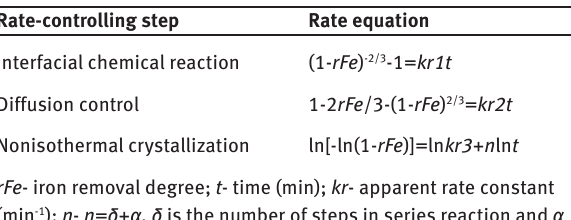
)] vs ln t obtained at temperatures of Fe